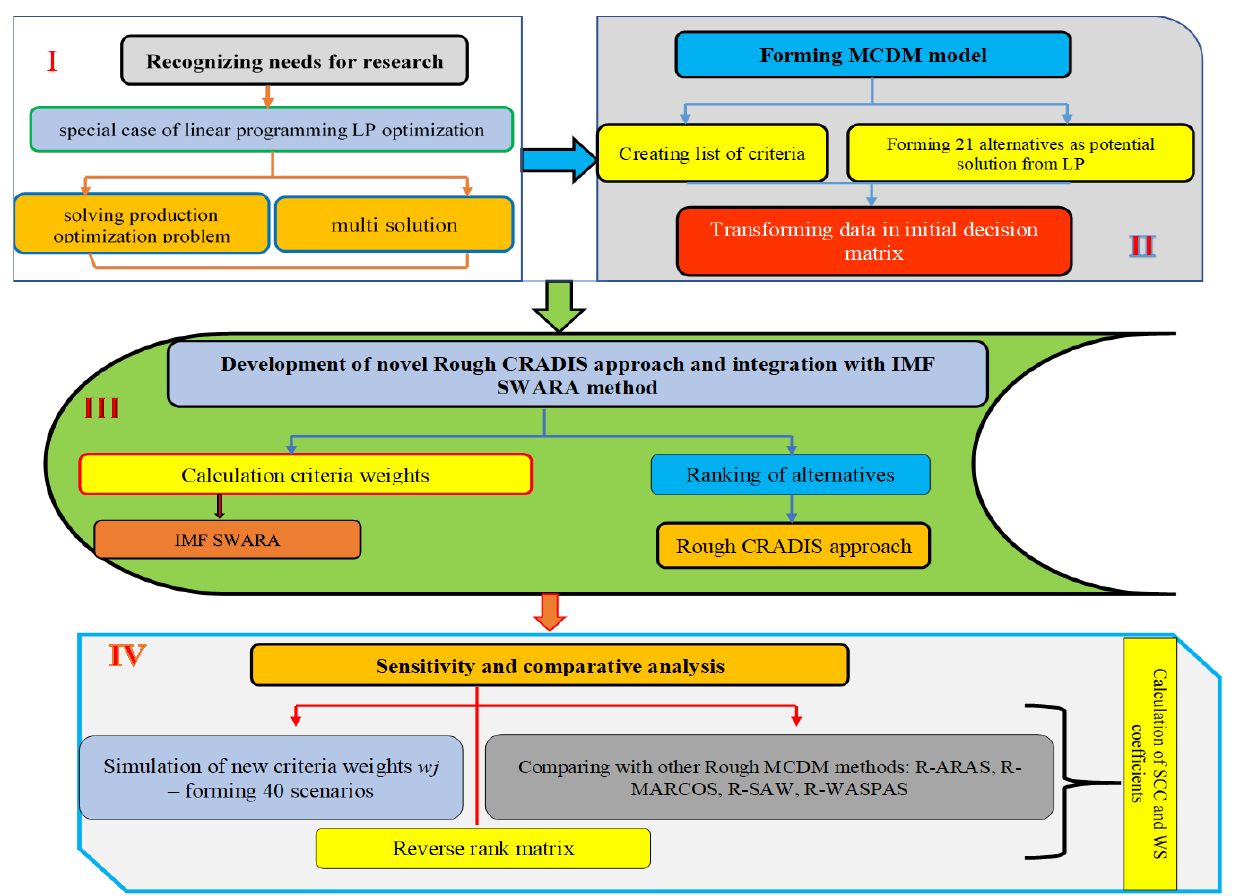
Figure 1. Research methodology .